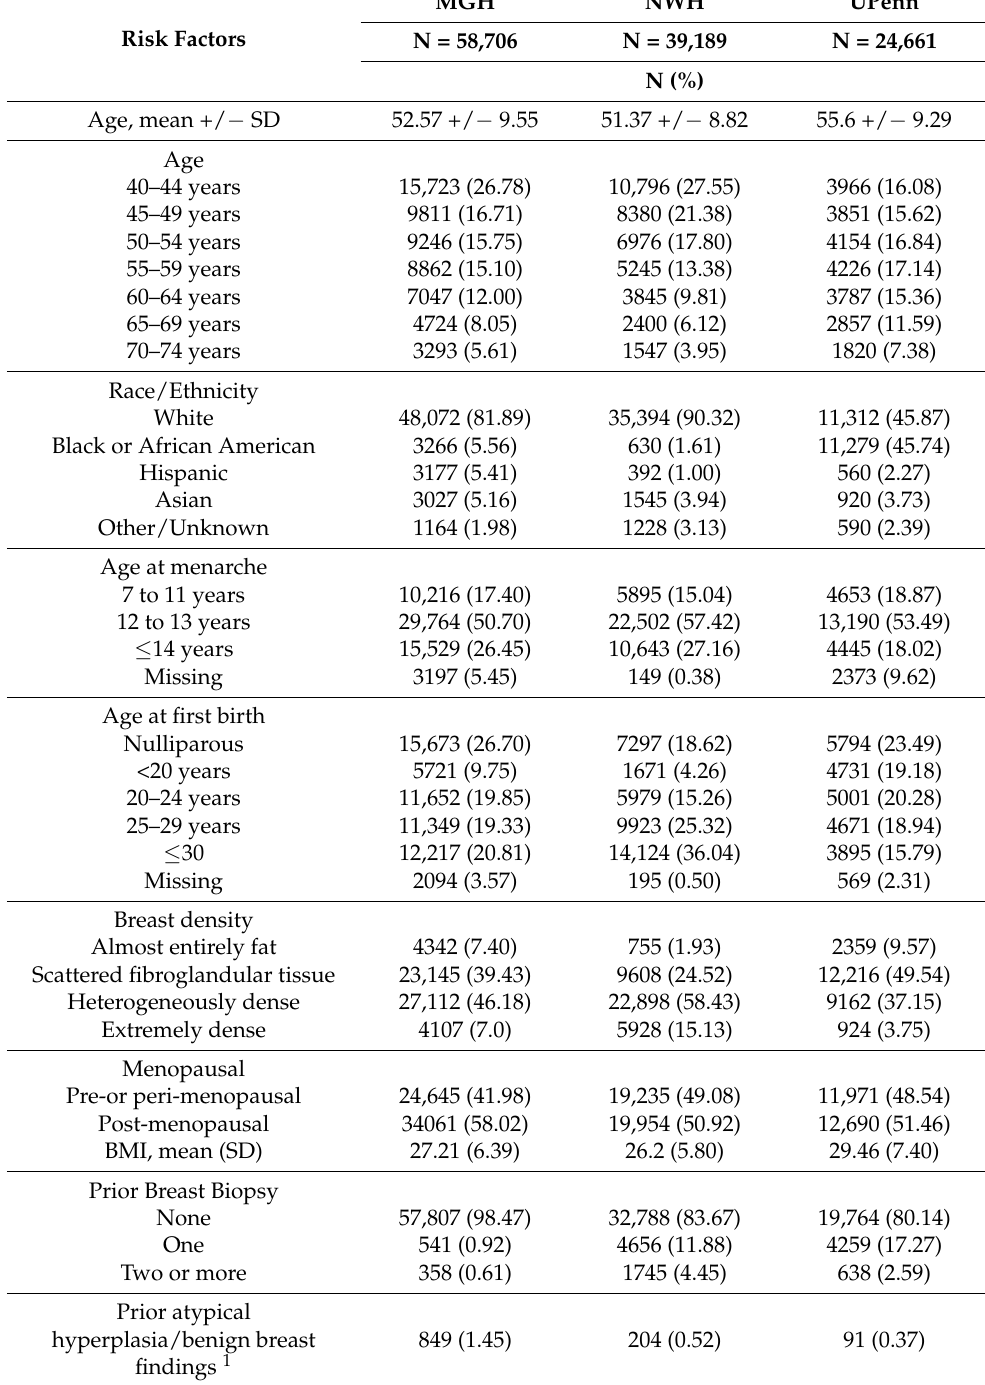
Table 1. Risk factors by study